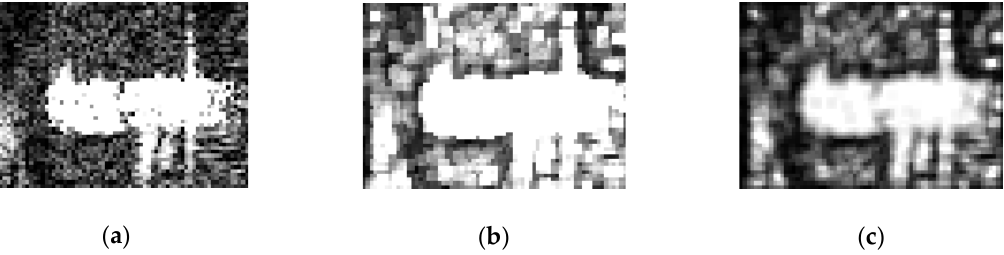
Figure 4. ( a ) Original synthetic aperture radar (SAR) image; ( b ) Saliency map by the local contrast measure (LCM); ( c ) Saliency map by Gaussian kernel function weighted local contrast measure (GLCM).